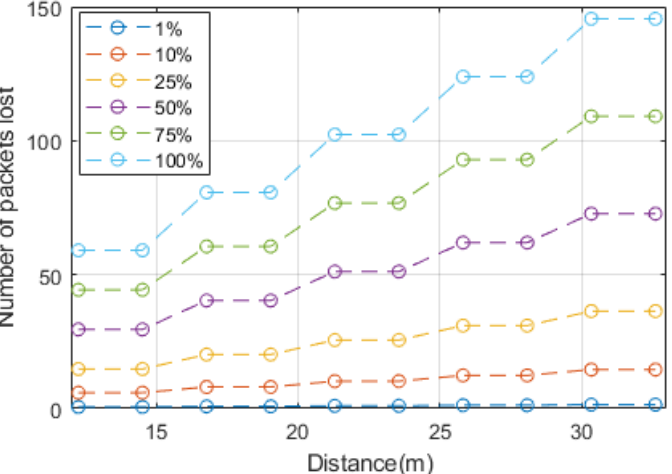
Figure 15. Pecentage of consecutive packet